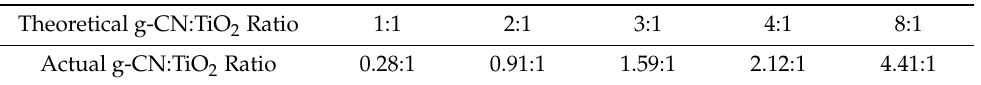
Table 1. Theoretical and actual g-CN:TiO 2 ratios determined by thermogravimetric analysis (TGA)